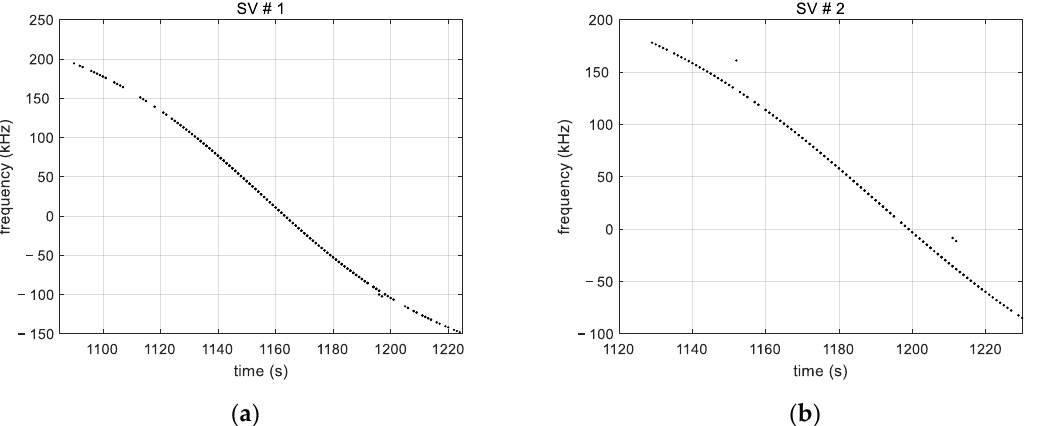
Figure 10. ( a ) Measured frequency for SV#1 after aggregating the multi-tone measurements of Figure 8a; ( b ) Measured frequency for SV#2 after aggregating the multi-tone measurements of Figure 8b.